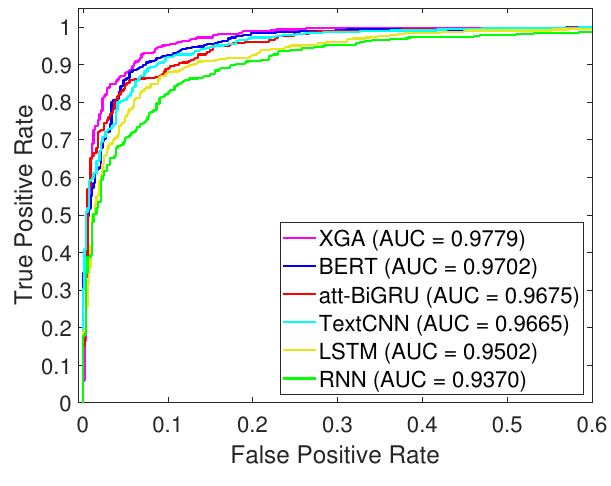
Figure 3. The ROC